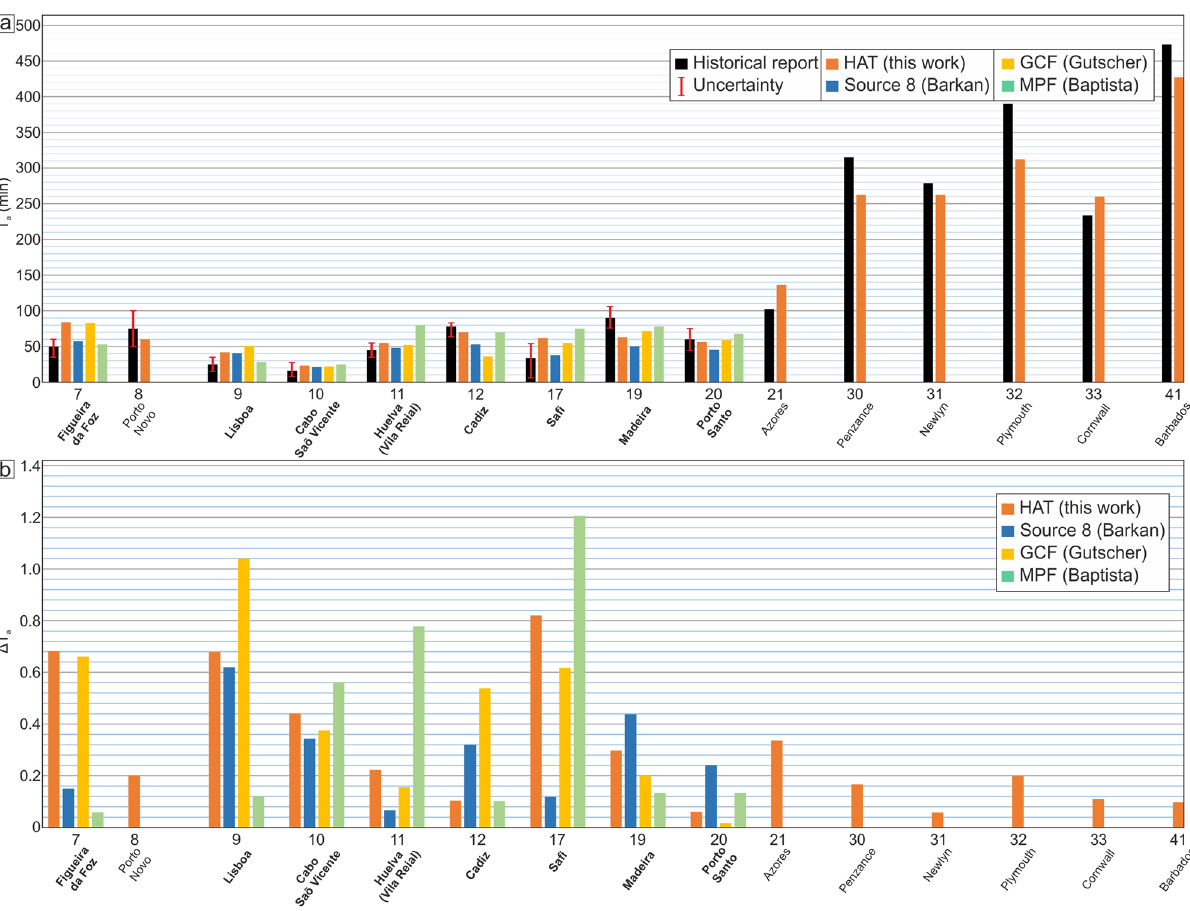
Fig. 6 Comparison between the arrival time of the 1755 tsunami at different locations according to historical reports and those obtained by tsunami ) and uncertainty of the 1755 Lisbon tsunami speci fi ed on historical reports 10 – 14,16 – 19,27,45 – 48 (black and simulations. a Graph showing the arrival time ( t obs a red error bar, respectively) and the arrival time obtained from the tsunami simulations ( t calc ) of different tectonic structures (HAT in orange, Source 8 27 in a blue, GCF 26 in yellow and MPF 11 in green). b Relative variation at different locations between the reported TTT and the TTT obtained from tsunami simulations speci fi ed in a . In bold are labelled locations with information available for comparison from the four tsunami